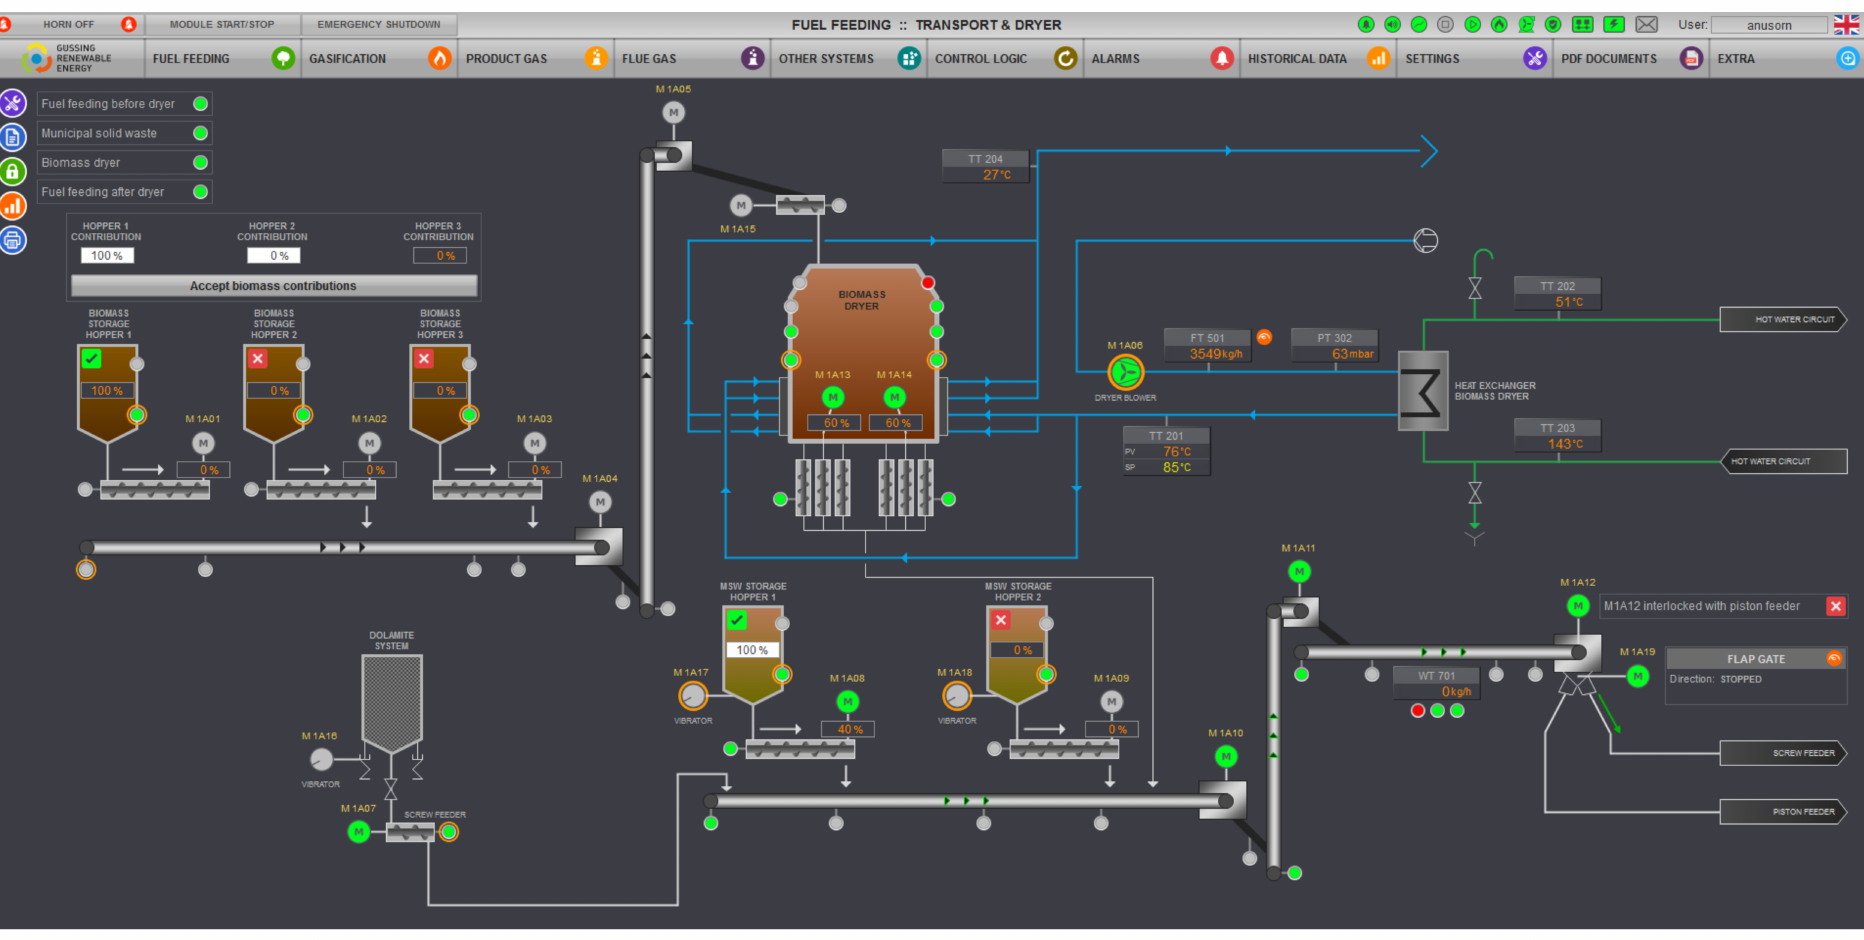
Figure 5. Process diagram of the fuel feeding